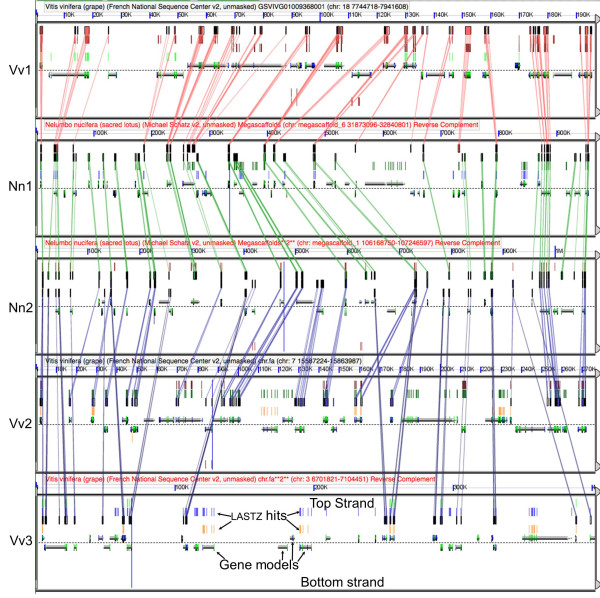
High resolution analysis of syntenic regions of Nelumbo nucifera (Nn1/Nm2) and Vitis vinifera (Vv1/Vv2/Vv3). Synteny regions were identified from Figure S5 in Additional file 1. Gene models are arrays in middle of each panel; Colored boxes and lines connect regions of sequence similarity (LastZ) for protein-coding sequences between pair-wise comparisons.